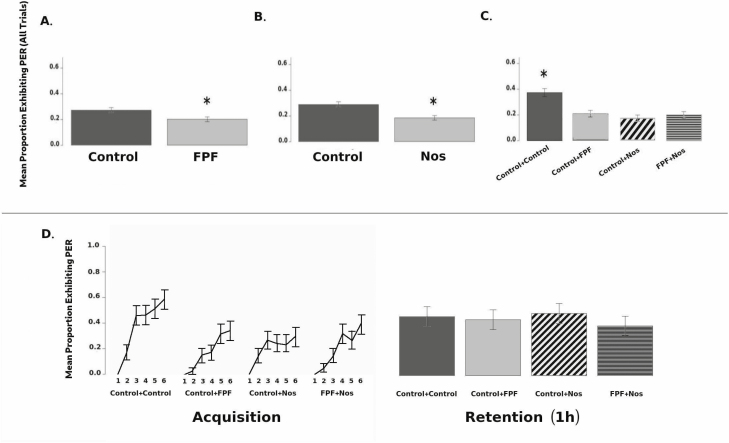
(A) Main effect of 9-d field-realistic exposure to FPF on PER. (B) Main effect of N. ceranea infection on PER. (C) Interaction between FPF and N. ceranae on PER. (D) Acquisition and retention for all four groups. Total n = 160; error bars are 95% confidence intervals; ANOVA, * P < 0.05.